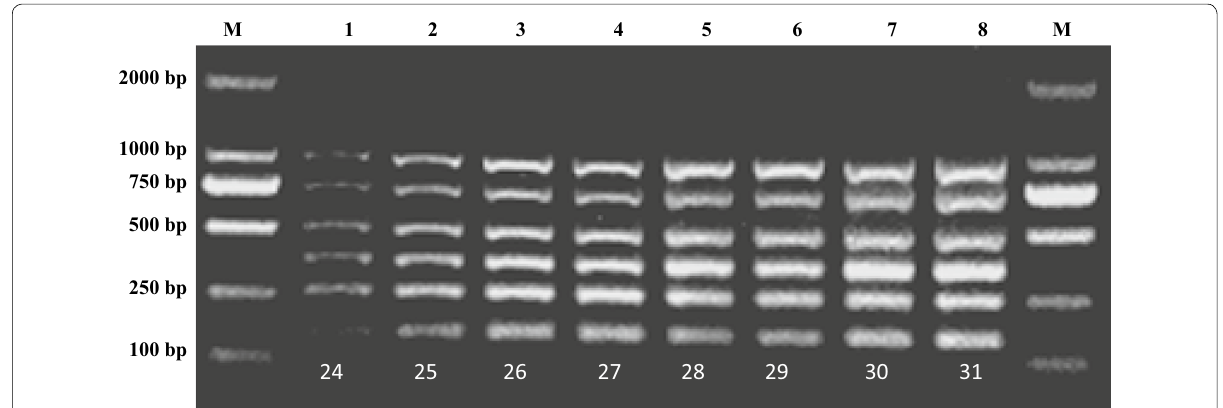
Fig. 3 Determination of time of the multiplex PCR. Lane M: 2000 bp DNA marker; Lane 1: 24 running cycles; Lane 2: 25 running cycles; Lane 3: 26 running cycles; Lane 4: 27 running cycles; Lane 5: 28 running cycles; Lane 6: 29 running cycles; Lane 7: 30 running cycles; Lane 8: 31 running cycles